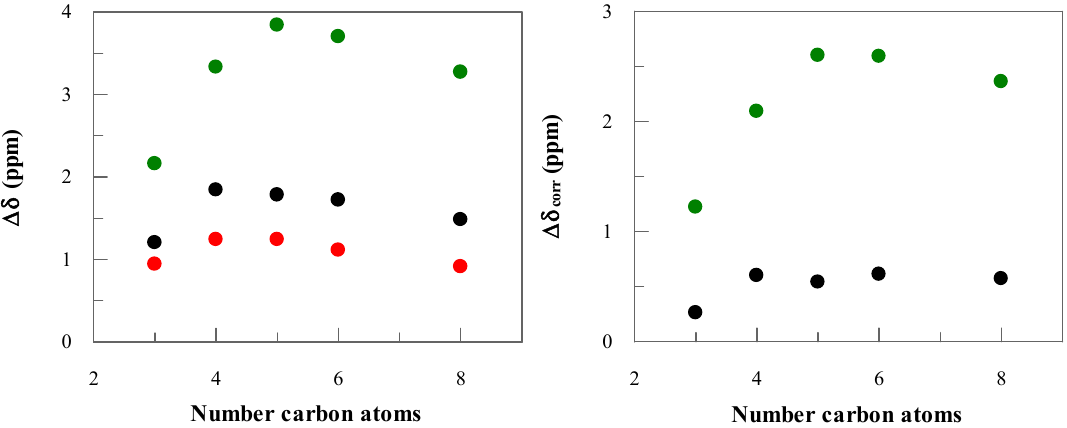
Figure 6. ( Left ) Influence of the number of carbon atoms in the alkyl chain of alkylsulfonate on the chemical induced upfield effect, Δ δ : ( ● ) Ha; ( ● ) Hb and ( ● ) Hc. ( Right ) Values of upfield effect for hydrogen atoms in positions ( ● ) Hb and ( ● ) Hc after correction by upfield effect of hydrogens Ha.